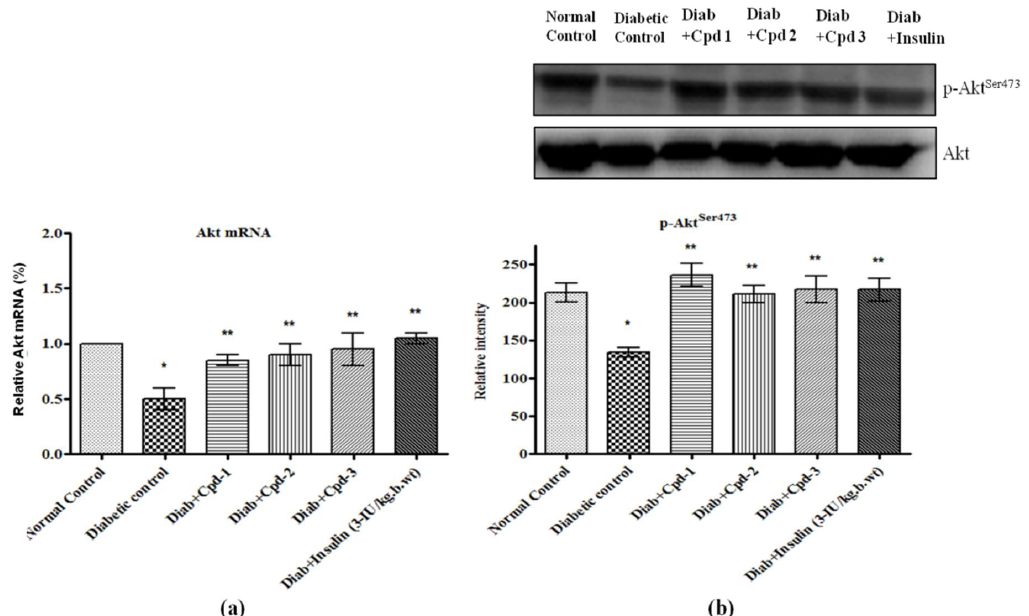
Figure 9. Effect of novel triterpenoids on ( a ) Akt mRNA; ( b ) p-Akt protein and expression in skeletal muscle of STZ-induced diabetic rats compared with the effect of insulin. The expression of mRNA and proteins was assessed by real-time PCR and Western blotting. β-actin was used as a loading control. Each bar represents mean ± SEM of 3 observations representing 6 animals. Significance at p < 0.05; *, compared with control; **, compared with diabetic control.